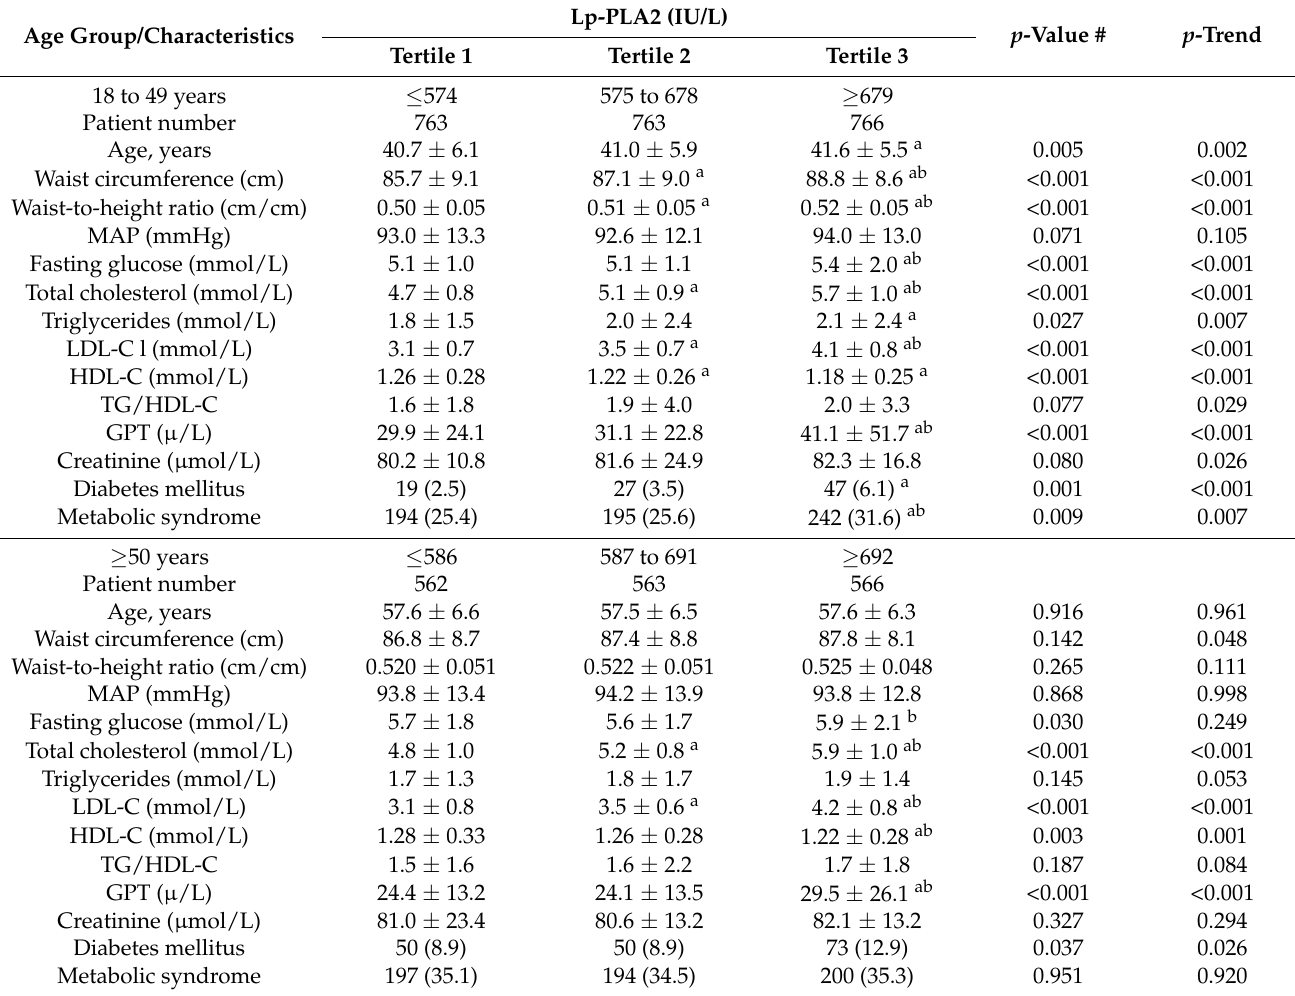
Table 3. Clinical and metabolic characteristics according to Lp-PLA2 level in